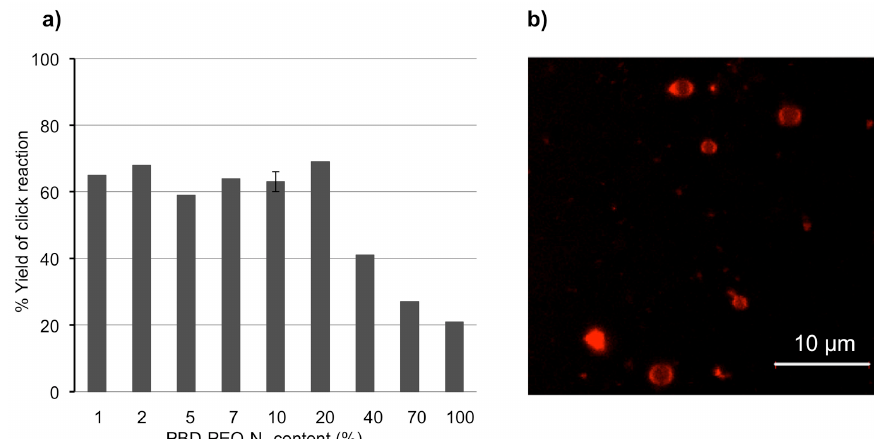
FIGURE 6 - a) Yield for the “click” conjugation between the dendron and polymersomes as a function of polymersome PBD-PEO-N content (remainder is PBD-PEO-OH); b) Well dispersed polymersomes resulting from the conjugation of dendron to polymersomes composed of 5:95 PBD-PEO-N 3